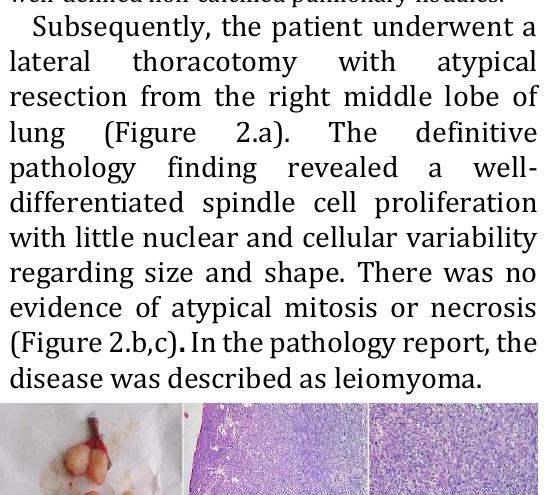
Figure 1: Computed tomography demonstrates a diffuse distribution of multiple well-defined non-calcified pulmonary nodules.